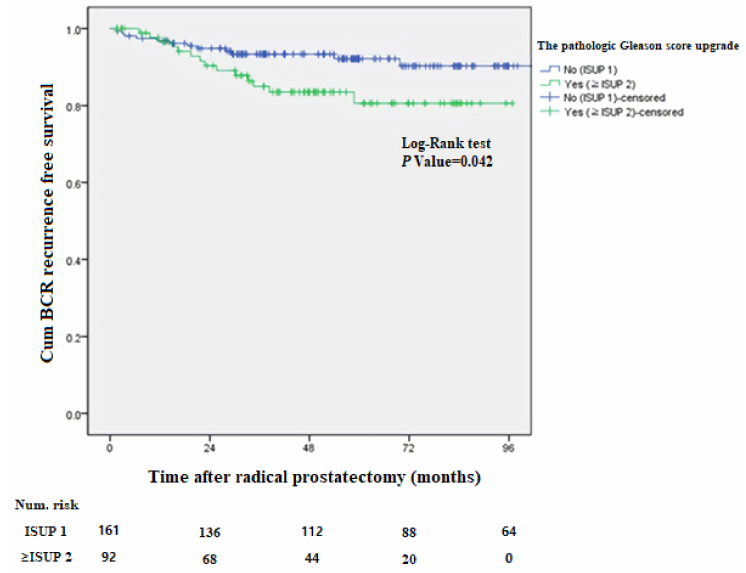
Figure 1. Kaplan–Meier curves for biochemical recurrence (BCR)-free survival in patients according to the pathologic Gleason score upgrade based on International Society of Urological Pathology